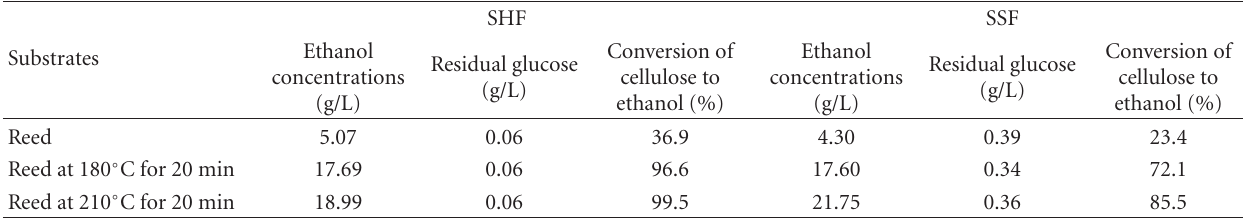
Table 3: Ethanol fermentation of WIS after LHW